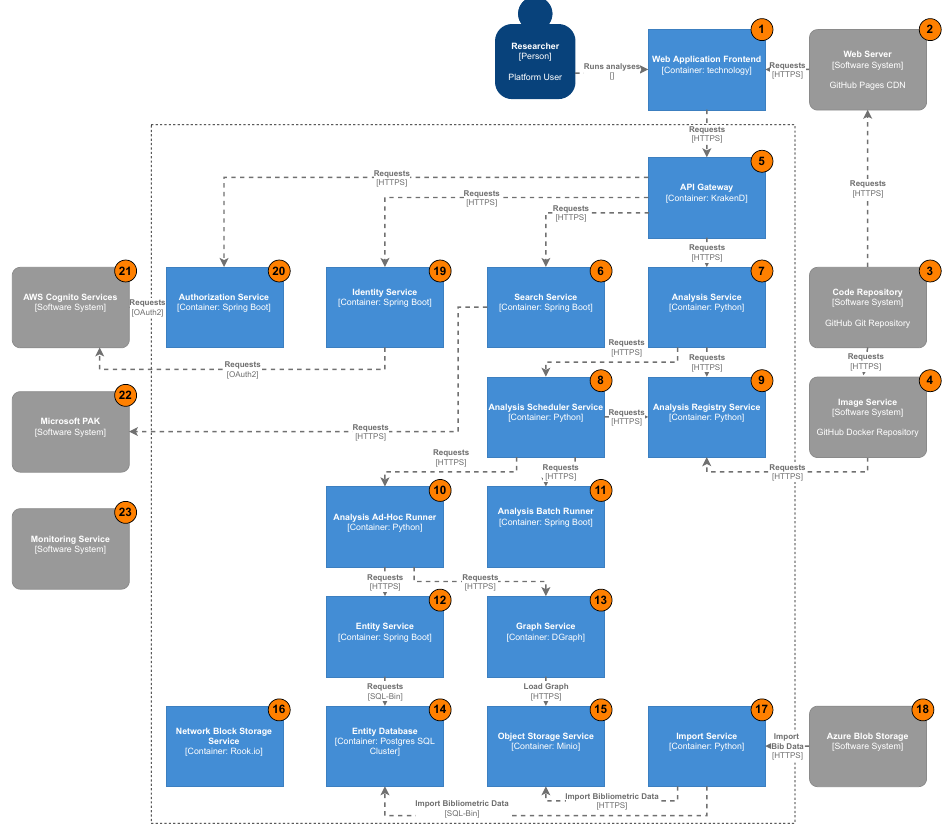
Figure 10. System containers and their relations within the software